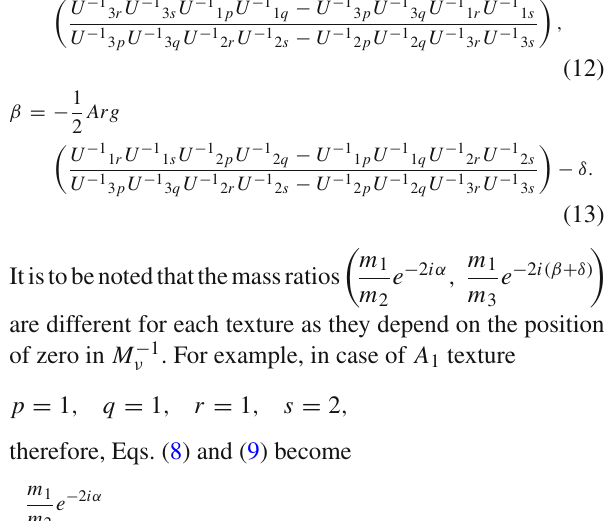
are different for each texture as they depend on the position of zero in M − 1 ν . For example, in case of A 1 texture p = 1 , q = 1 , r = 1 , s = 2 , therefore, Eqs. (8) and (9) become